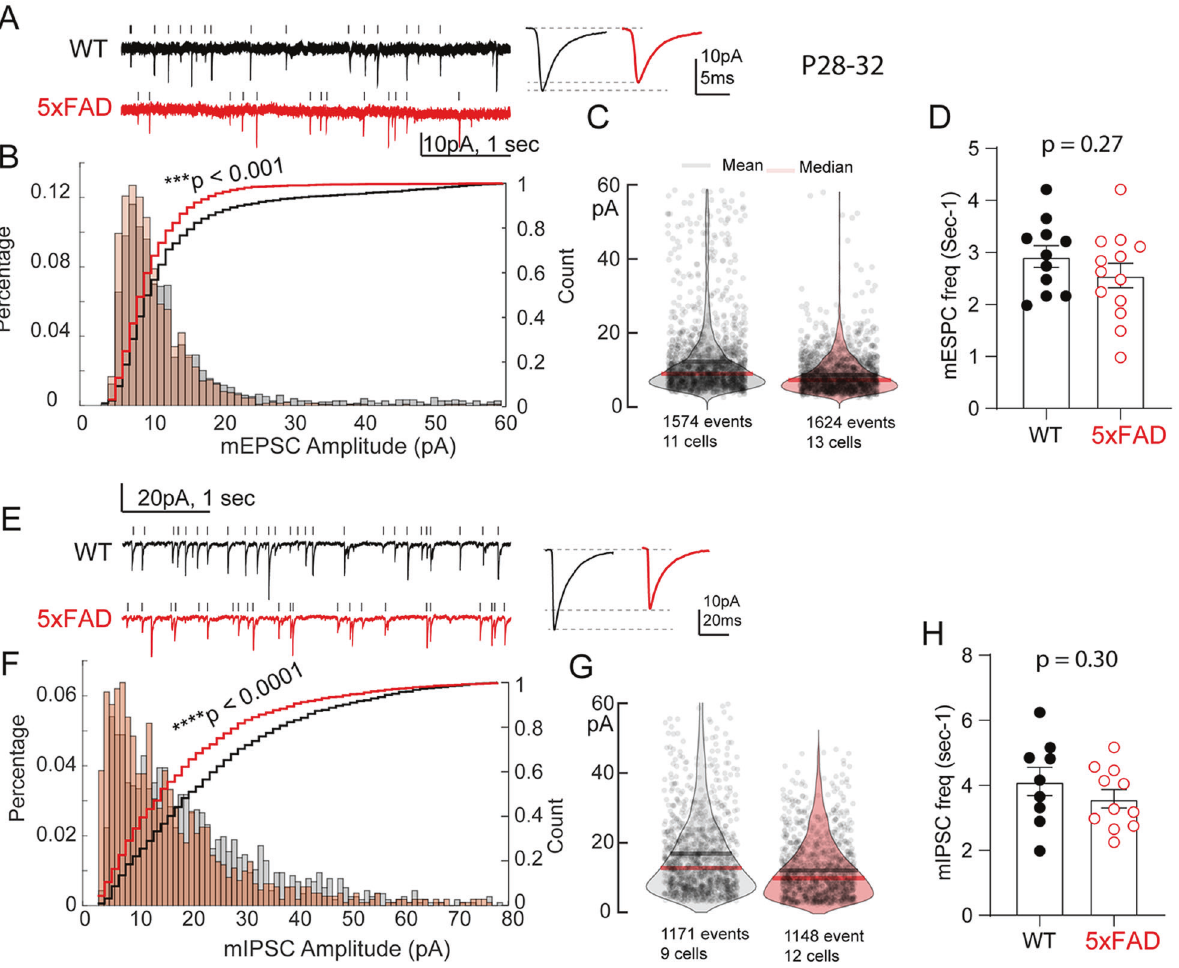
Fig. 4 5XFAD VC-L5 neurons show reduced spontaneous synaptic mEPSC and mIPSC inputs during critical period (P28 – 32). A Representative whole cell patch clamp recording (5-sec traces) of spontaneous mEPSC from 5XFAD and WT neurons. Vertical ticks indicate time stamps for detected mEPSCs. B A larger percentage of mEPSC amplitudes from 5XFAD neurons distributes to the smaller amplitude bins. There was signi fi cant difference between the two cumulative distribution curves (K-S test, D = 0.204, *** P < 0.001). C Violin plot of all mEPSC amplitudes from both groups. D 5XFAD VC-L5 neurons did not differ in mEPSC frequency (WT, n = 11 cells/6 mice; 5XFAD, n = 13 cells/7 mice. p = 0.27). E Representative traces of spontaneous mIPSCs (4-sec traces) from 5XFAD and WT neurons. F A larger fraction of mIPSC amplitudes from 5XFAD neurons also distributed to the lower amplitude bin, with a signi fi cant difference in the cumulative distribution curves (K-S test, D = 0.124, *** *p < 0.0001). G Violin plot of all analyzed mIPSC amplitudes from both groups. H 5XFAD neurons showed similar mIPSC frequency (WT, n = 9 cells/6 mice; 5XFAD, n = 11 cells/7 mice. p = circuit development. The hemizygote 5xFAD mouse model over- expresses human amyloid precursor protein (APP) and presenilin 1 (PS1) harboring fi ve familial AD mutations [10]. In this model, age-